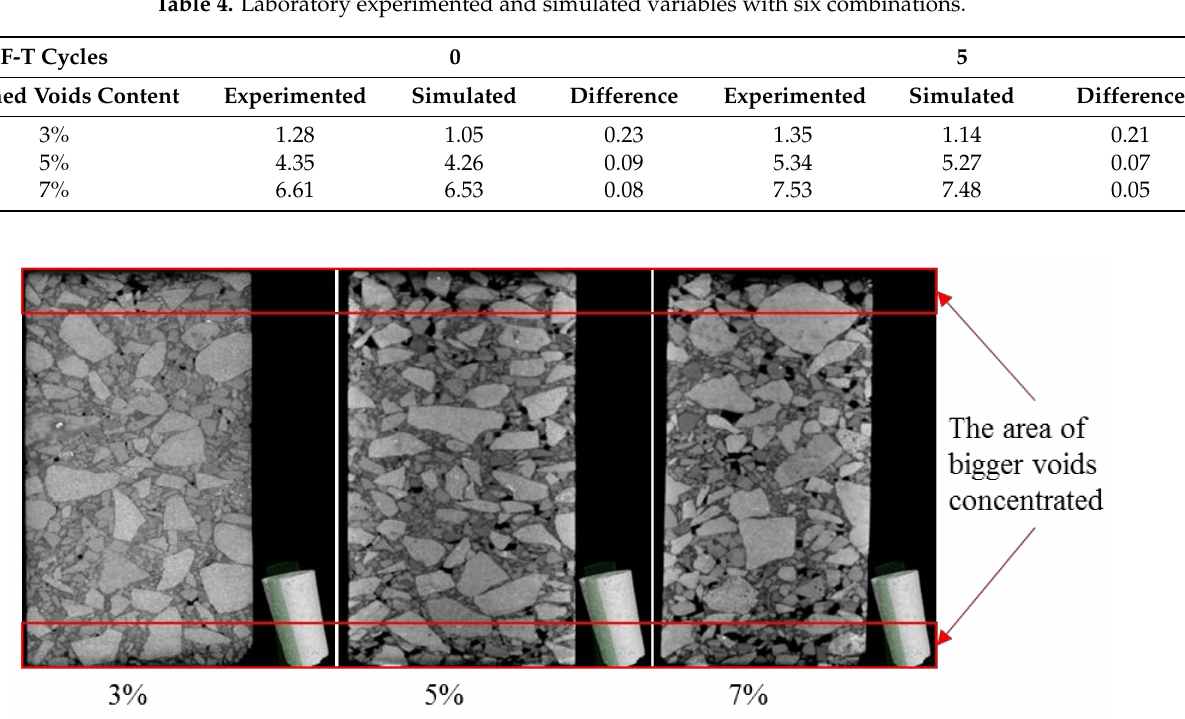
Figure 5. Air void distribution of different samples’ determined from 2D slices (vertical direction). Comparison of the difference between measured and simulated results